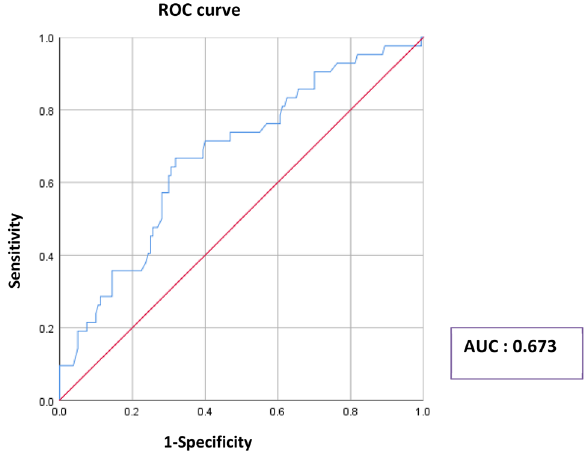
Figure 2. Area under the curve of the maximum standardized uptake value (SUVmax) predicting tumor- infiltrating lymphocyte (TIL) levels ≥